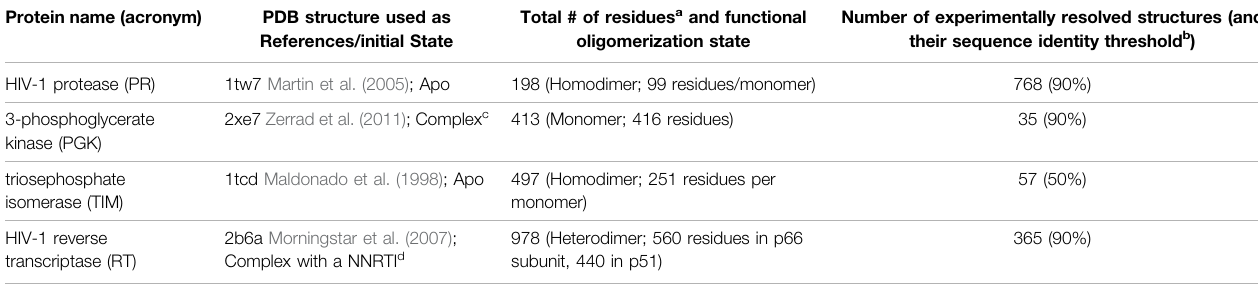
TABLE 1 | Proteins used as case studies, and corresponding structural data from experiments. Protein name